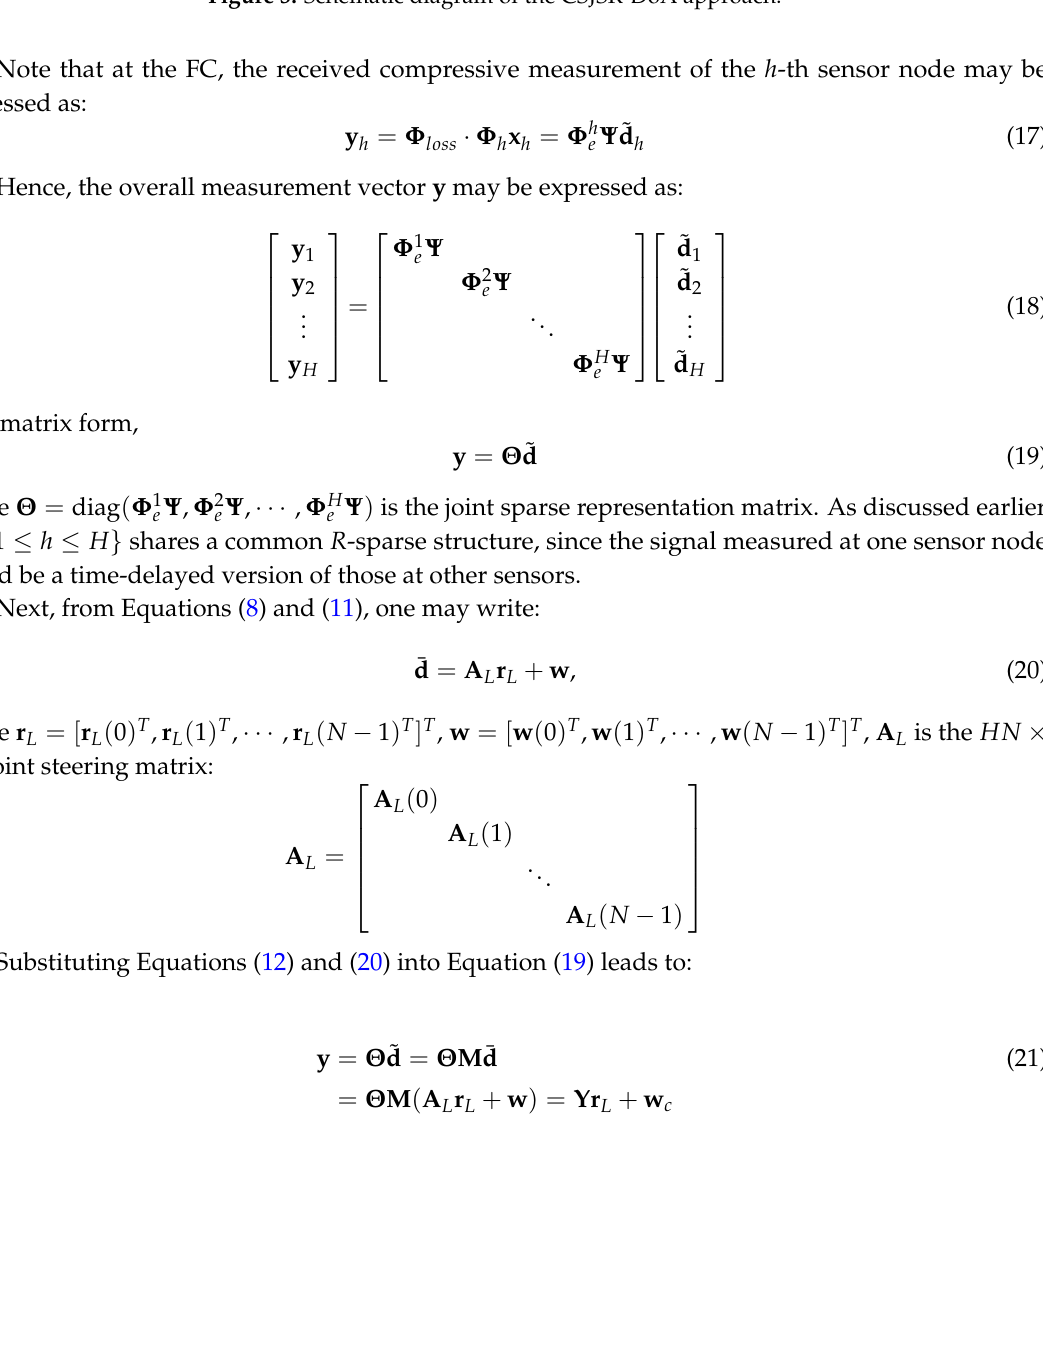
Figure 3. Schematic diagram of the CSJSR-DoA